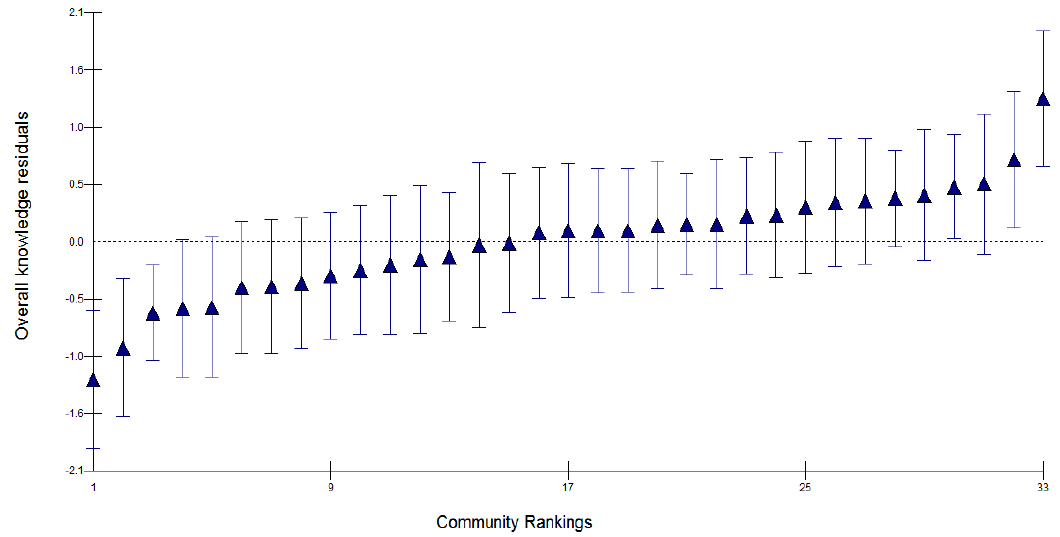
Figure 1. Catapillar plot of diarrhoea knowledge residuals ranked by sampled communities. The dotted line is the mean of the estimated (shrunken) residuals * which is equal to zero. The triangles indicate estimated (shrunken) community